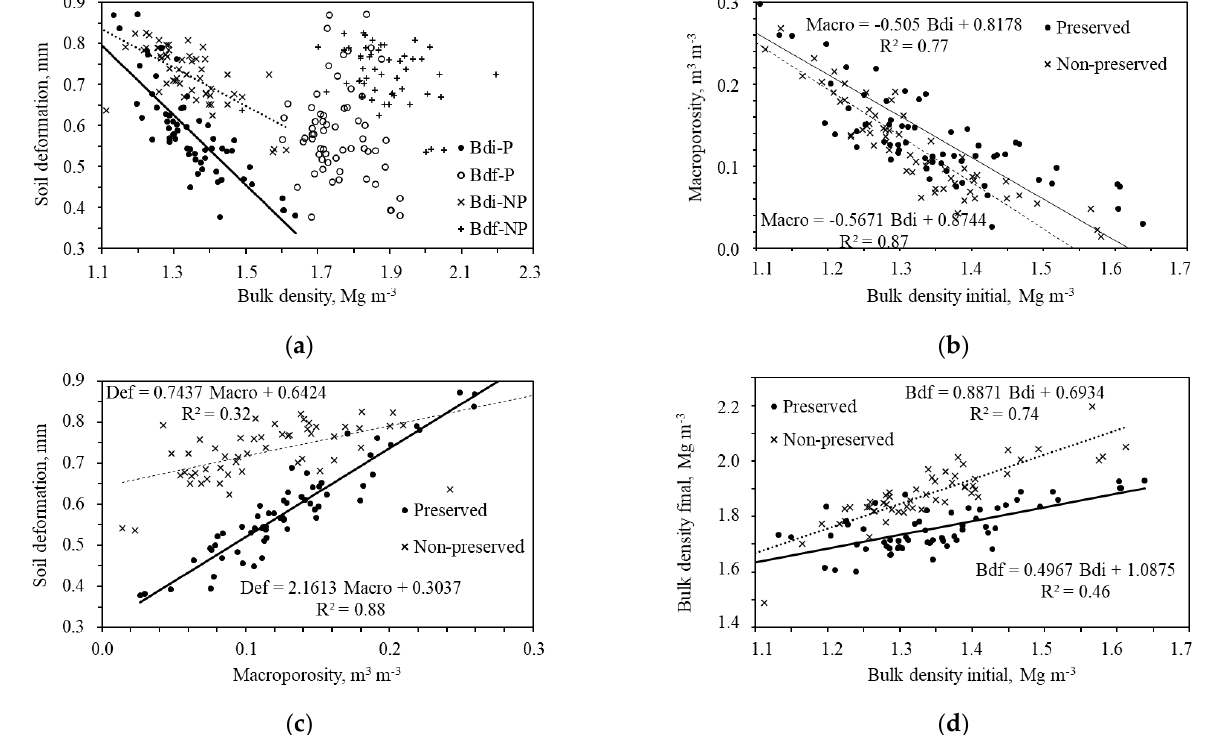
Figure 6. Regression between physical properties for soil with preserved (P) and non-preserved (NP) structure. Macro = macroporosity; Bdi and Bdf = bulk density in the beginning and in the final of the uniaxial compression test, respectively; Def = soil deformation in the final of the uniaxial compression test.